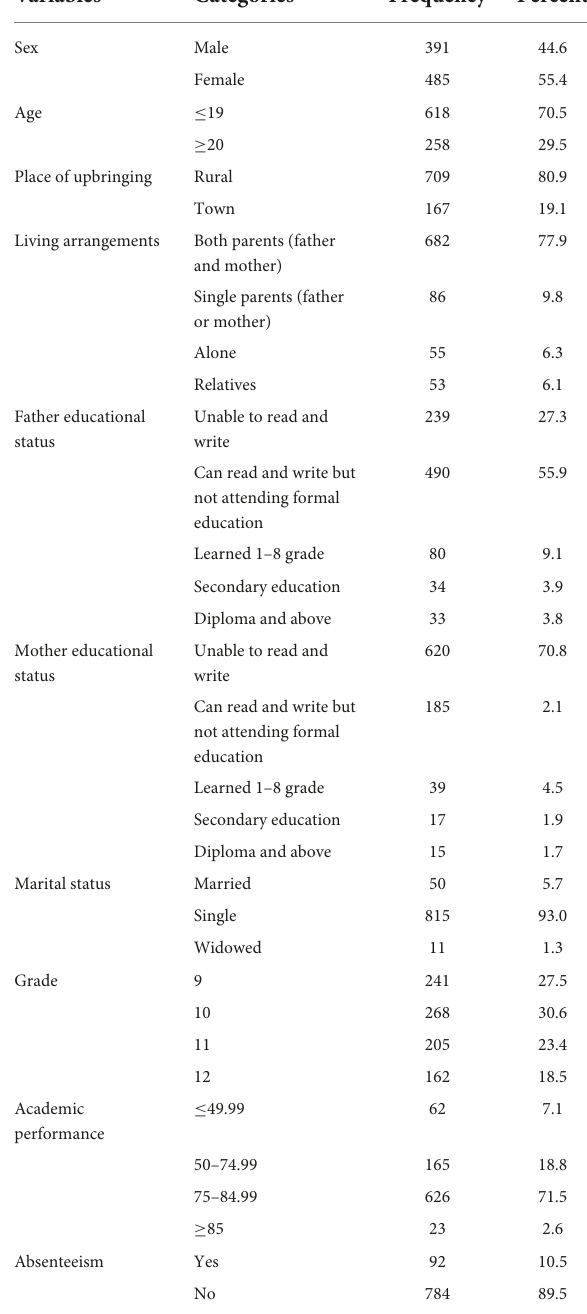
TABLE 1 Socio-demographic characteristics of participants among high school adolescents in Northwest Ethiopia ( n = 876), 2021 Gorgonian Calendar